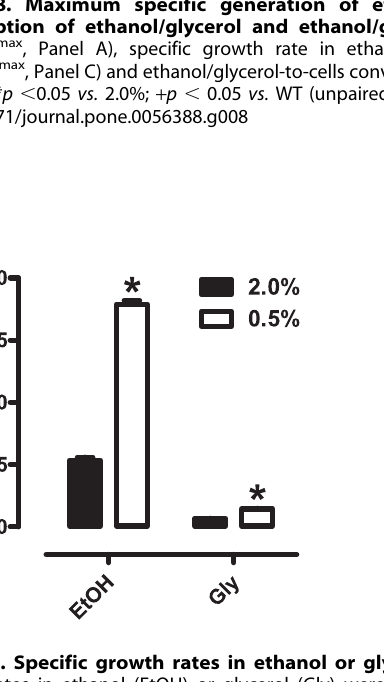
Figure 9. Specific growth rates in ethanol or glycerol. Specific growth rates in ethanol (EtOH) or glycerol (Gly) were determined as described in Materials and Methods , with cells removed from their original media and added to media containing each of these substrates (8.98 g/L ethanol and 0.68 g/L glycerol). *p , 0.05 vs. 2.0% (unpaired Student